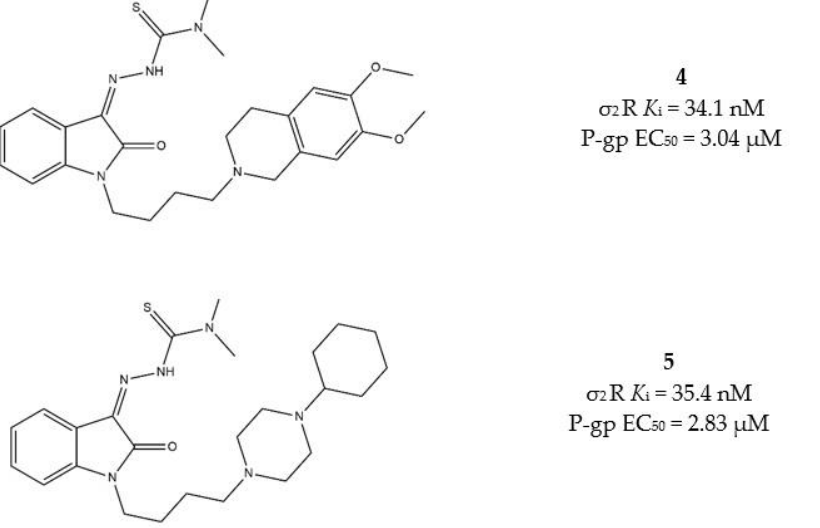
Figure 7. Structures 4 and 5 and their K i for σ 2 receptors and EC 50 values for P-gp.